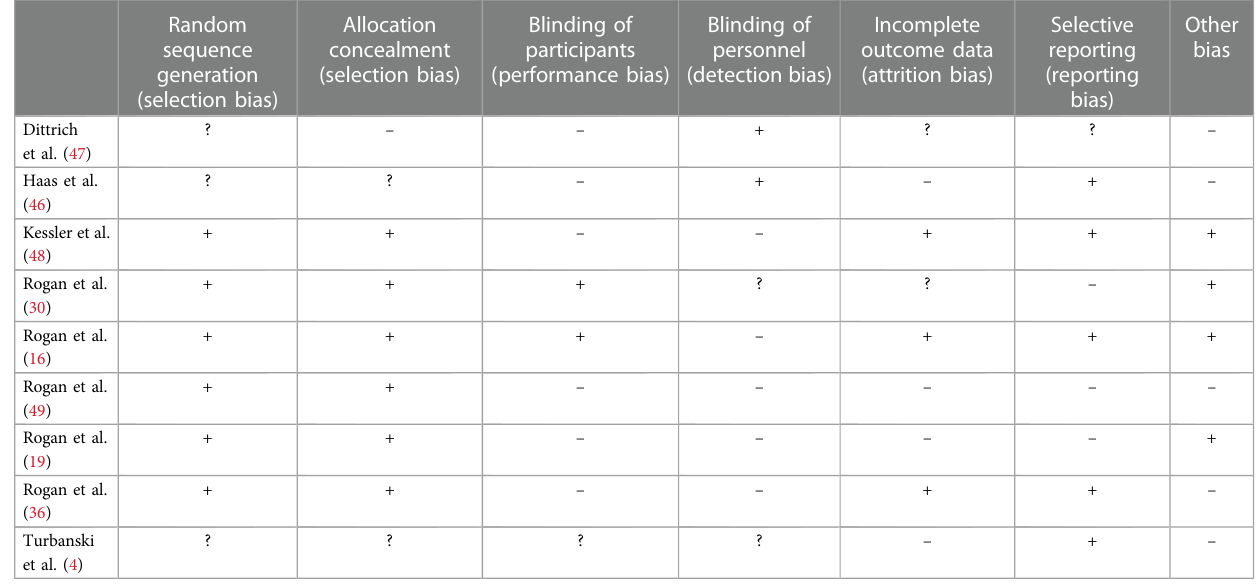
TABLE 3 Risk of bias of the included